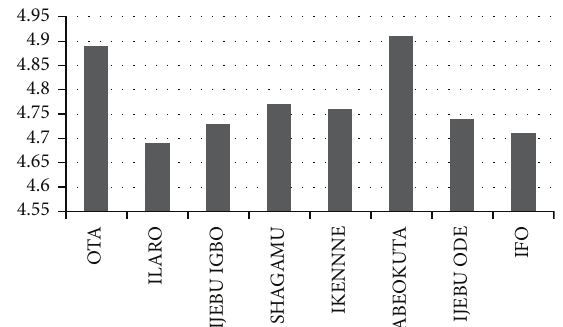
Figure 1: Graph showing average monthly solar insolation for Ogun State,